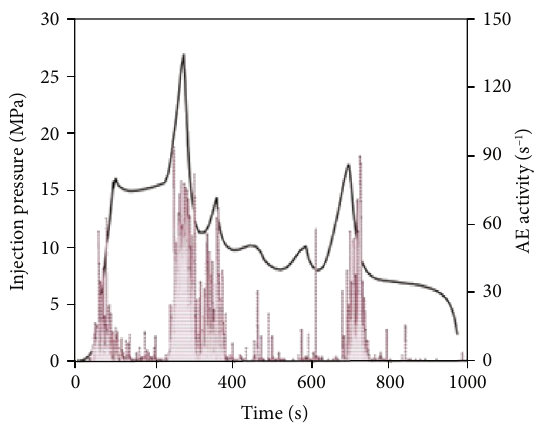
Figure 11: The injection pressure curve and AE activity of Sample 5#.